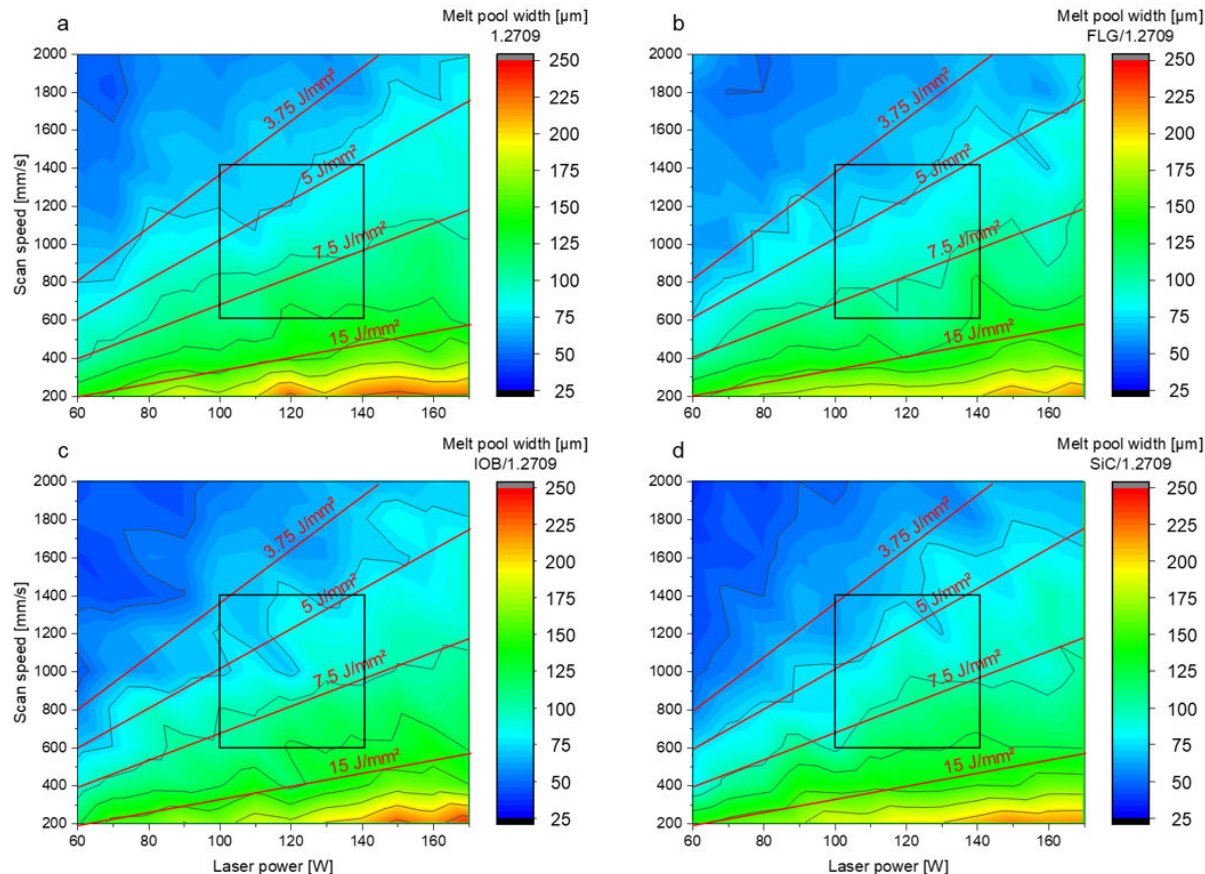
Figure 9. Melt pool width with respect to laser power and scan speed of ( a ) 1.2709 feedstock material, ( b ) FLG/1.2709 (0.75 vol.%), ( c ) IOB/1.2709 (1 vol.%), ( d ) SiC/1.2709 (1 vol.%). Parameter window for cuboid specimens highlighted by black